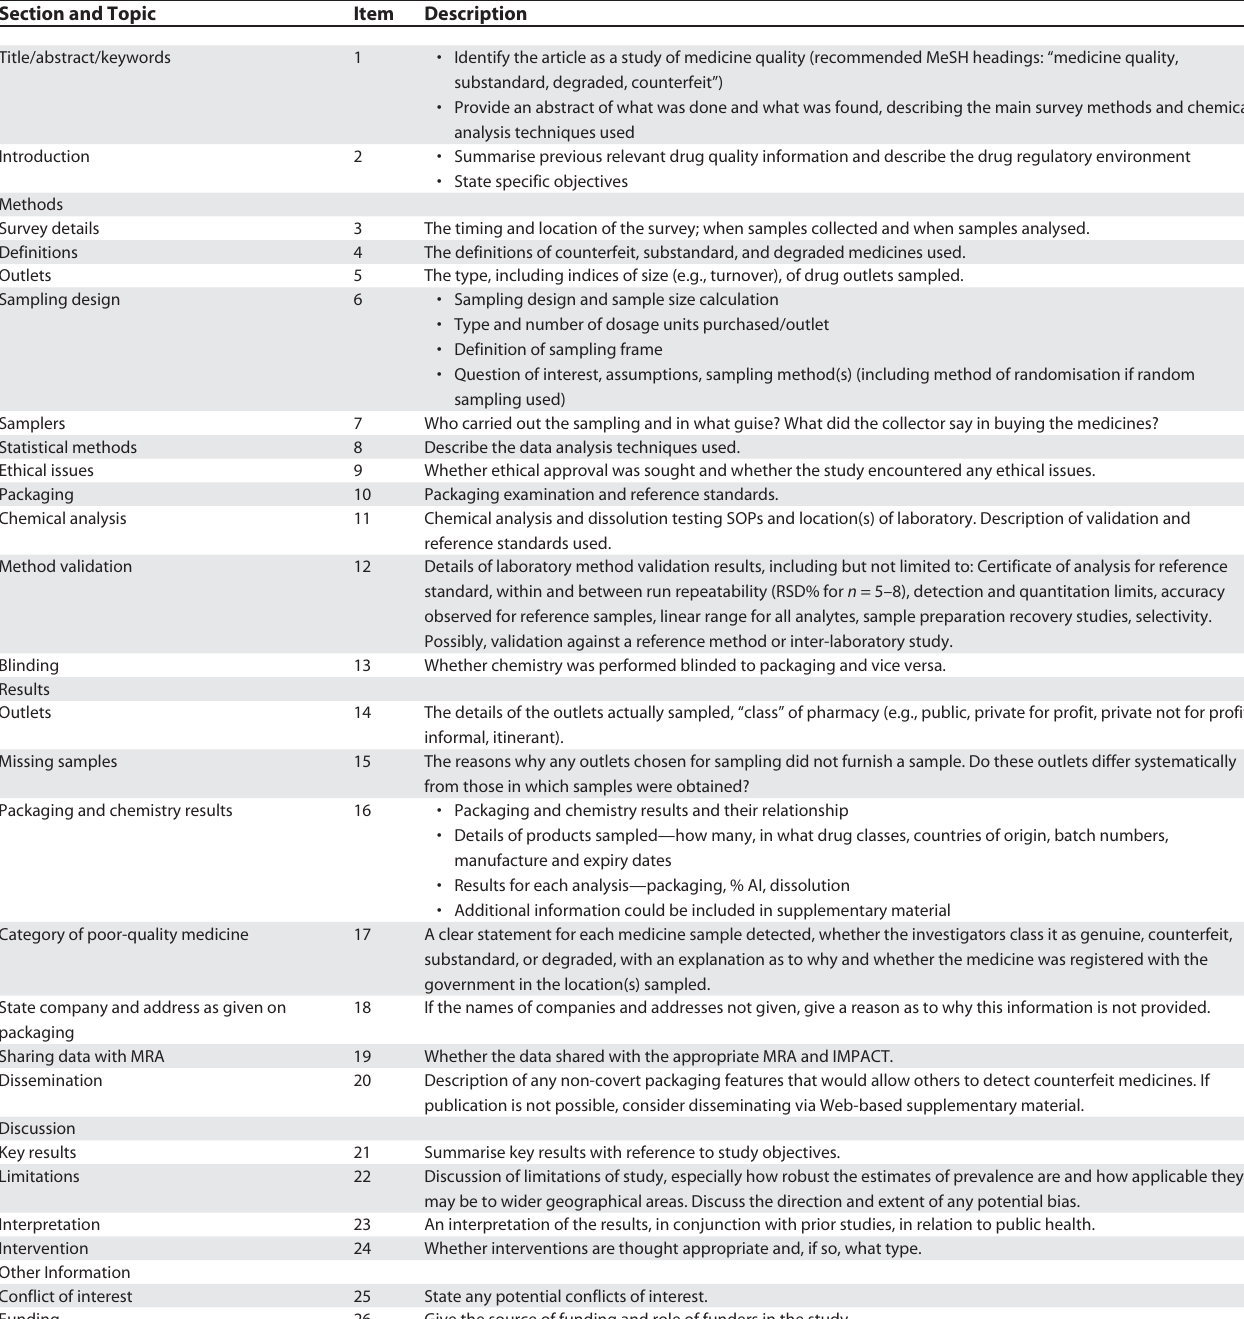
Table 1. MEDQUARG Checklist of Items That We Suggest Should Be Addressed in Reports of Surveys of Medicine